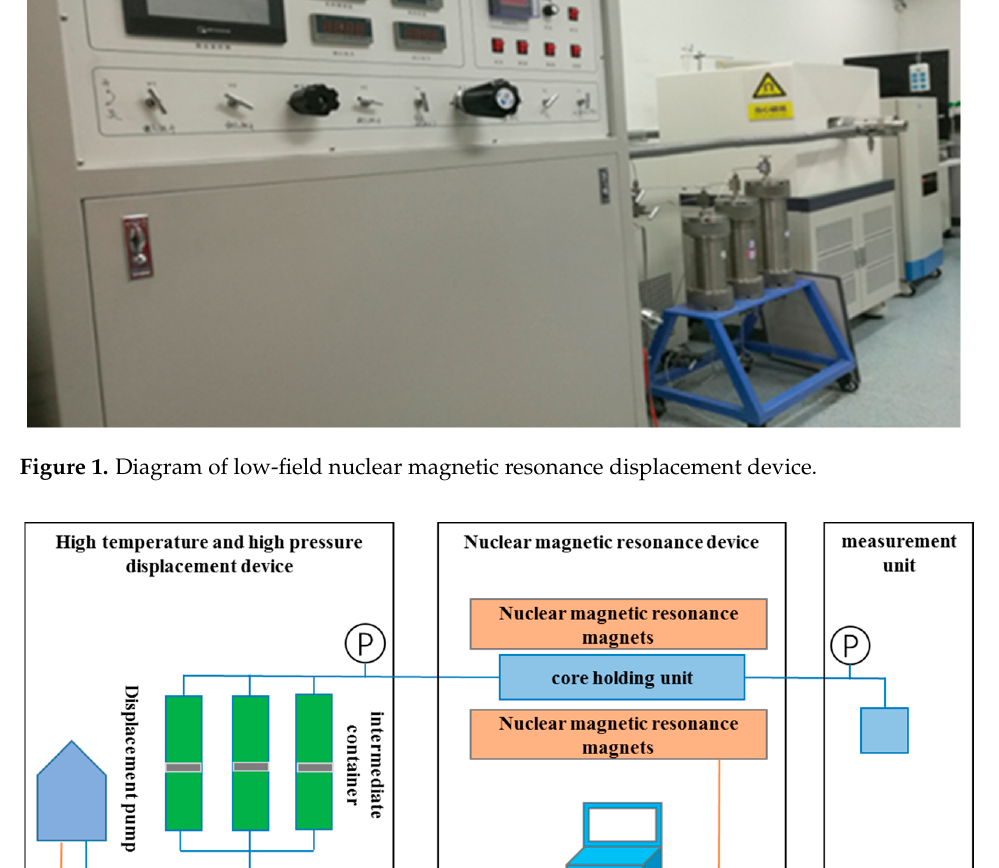
Figure 2. Schematic diagram of low-field nuclear magnetic resonance displacement device.